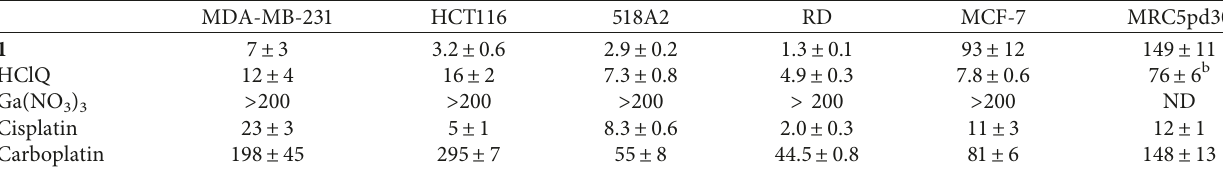
Table 1: IC a [ μ M] for 1 in the various cell lines as determined by MTT assay after 72h of incubation. 50 values